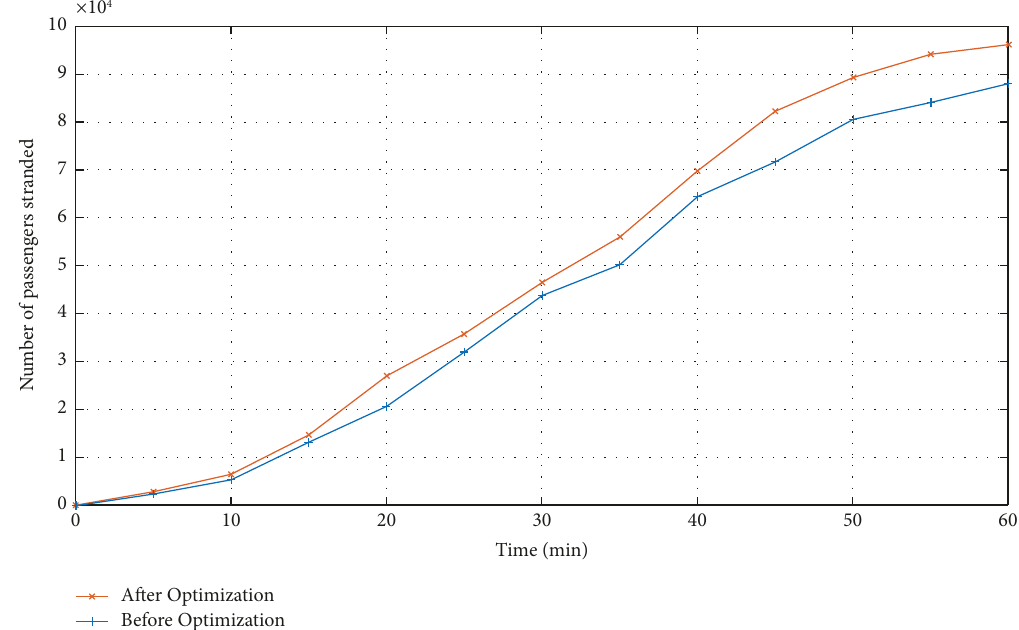
Figure 9: Comparison of the total numbers of people stranded in the peak period before and after